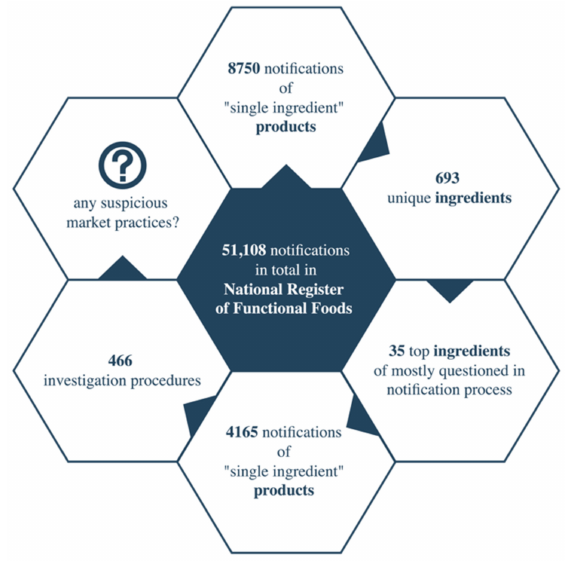
Figure 3. Scheme of input data for the analysis of the national